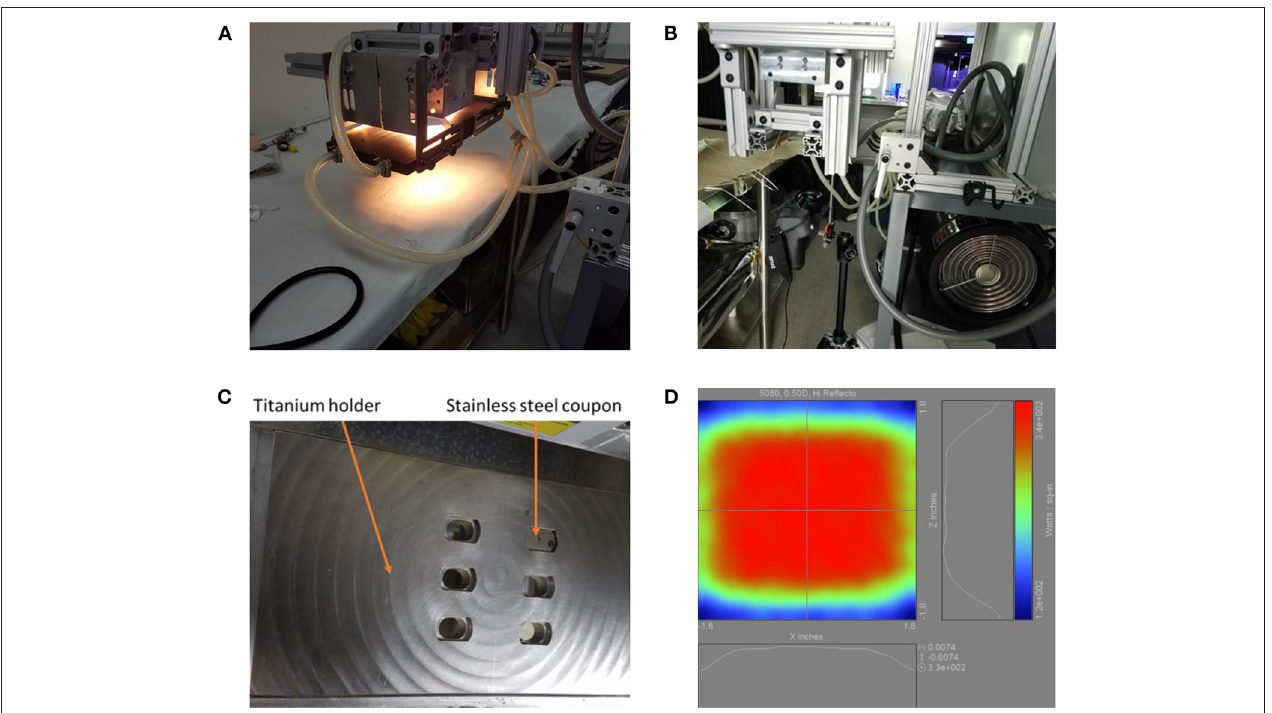
FIGURE 1 | The 5080 high temp infrared heater lamp setup. (A) The lamp is shown turned on. White light appears in the photo, but the majority of the light originating out of the bulbs is infrared. (B) The IR heat exposure setup including the FLIR T650sc camera, 5080 high temp IR heater lamp, and the titanium holder support structure consisting of 80/20 aluminum. (C) The titanium coupon holder with one stainless steel coupon inserted. (D) Projected heating profile for objects under the